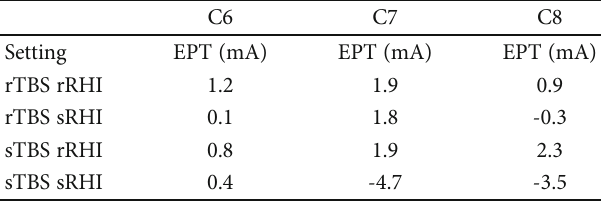
Table 2: SCI patient: di ff erence “ before minus after ” of electrical perception test (EPT) of the di ff erent dermatomes C6, C7, and C8 in milliampere. Electrical perception test of di ff erent dermatomes in the